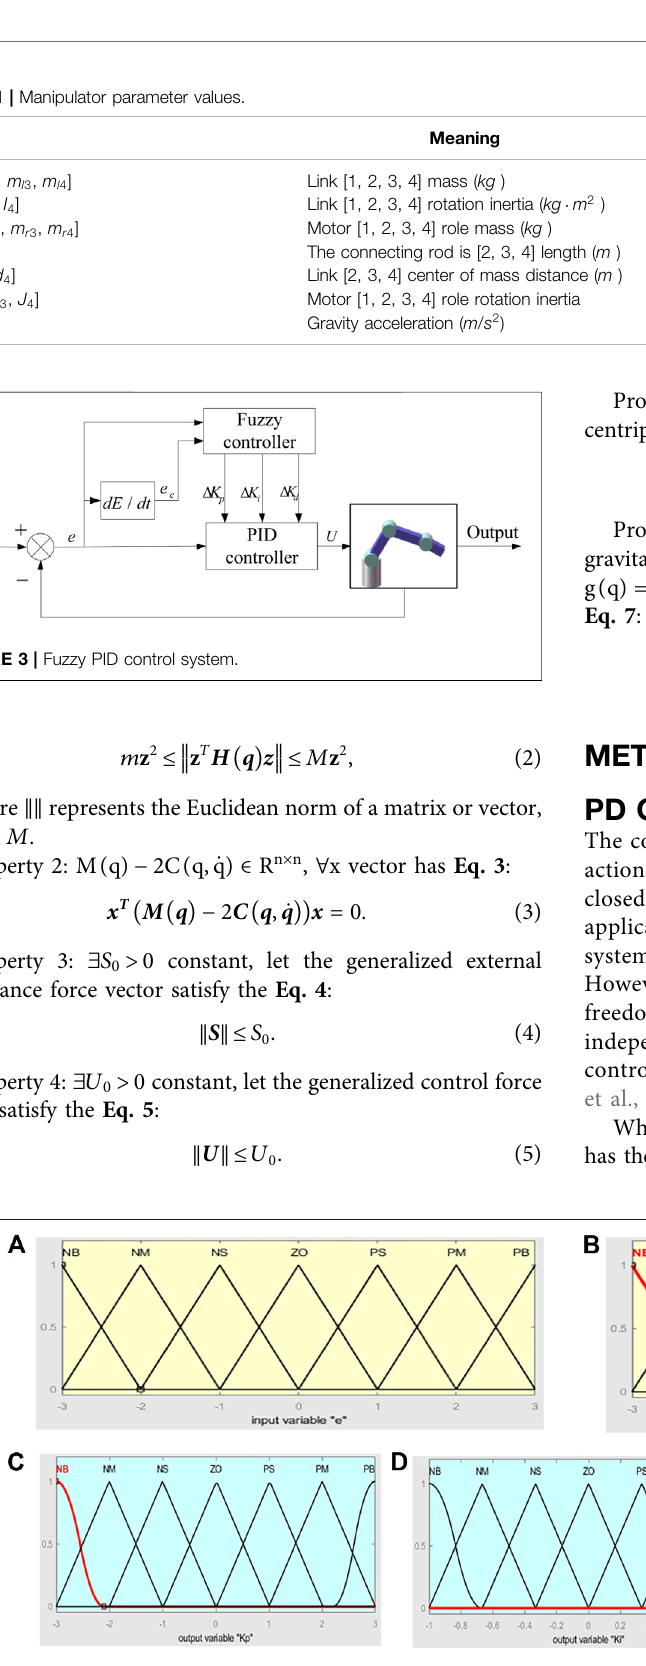
FIGURE 4 | Degree of membership function ( A : e , B : e c , C : Δ K p , D : Δ K i , E : Δ K d ).